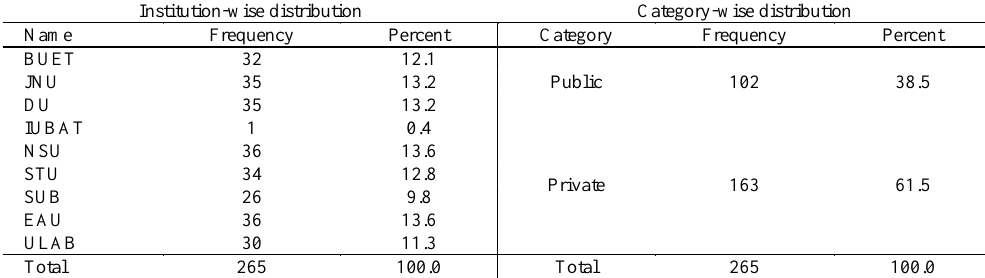
Table 1: Institution-wise and category-wise distribution of the respondents